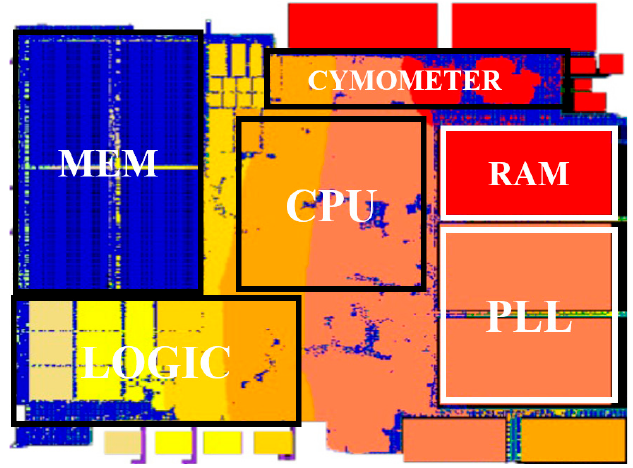
Figure 13. Simulate static power consumption distribution. Table 4. Actual measured static power consumed by di ff erent modules.